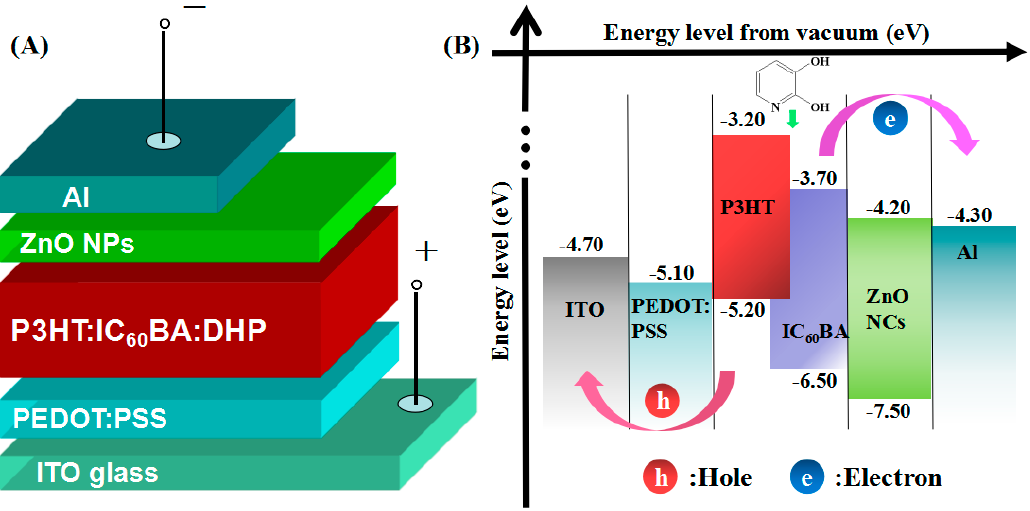
Figure 1. ( A ) Device schematic and ( B ) energy level band diagram.